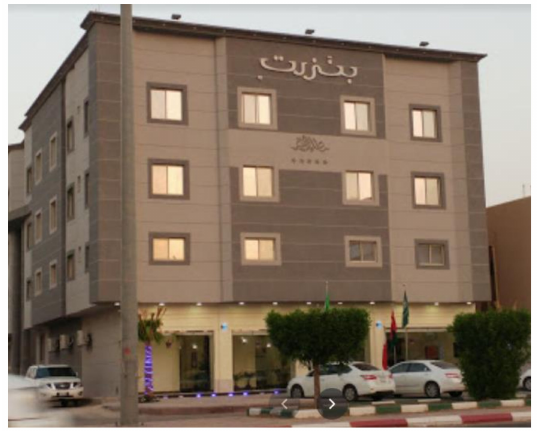
Figure 5. Site construction of underground room from digging to finishing and set-up of the equip- ment in the underground room; view of the building which has a normal room to compare it with the underground